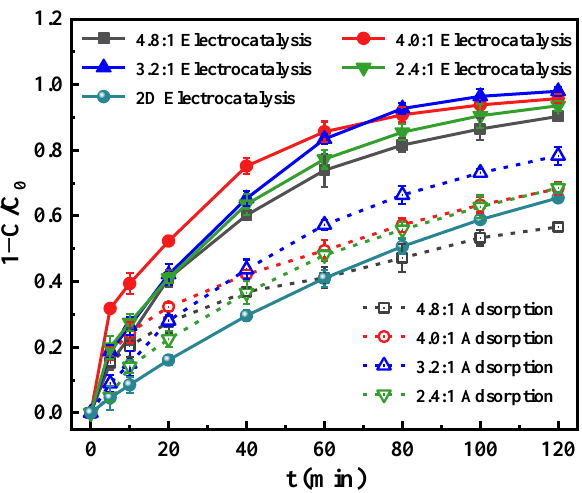
Figure 6. Effect of ZnCl 2 dosage on the removal efficiency of metronidazole ([metronidazole] 0 = 15 mg L −1 , [Na 2 SO 4 ] 0 = 0.05 mol L −1 , current density = 8.00 mA cm −2 , particle electrode dosage = 6.67 g L −1 , solution pH = 7, air aeration rate = 0.4 L min −1 ).